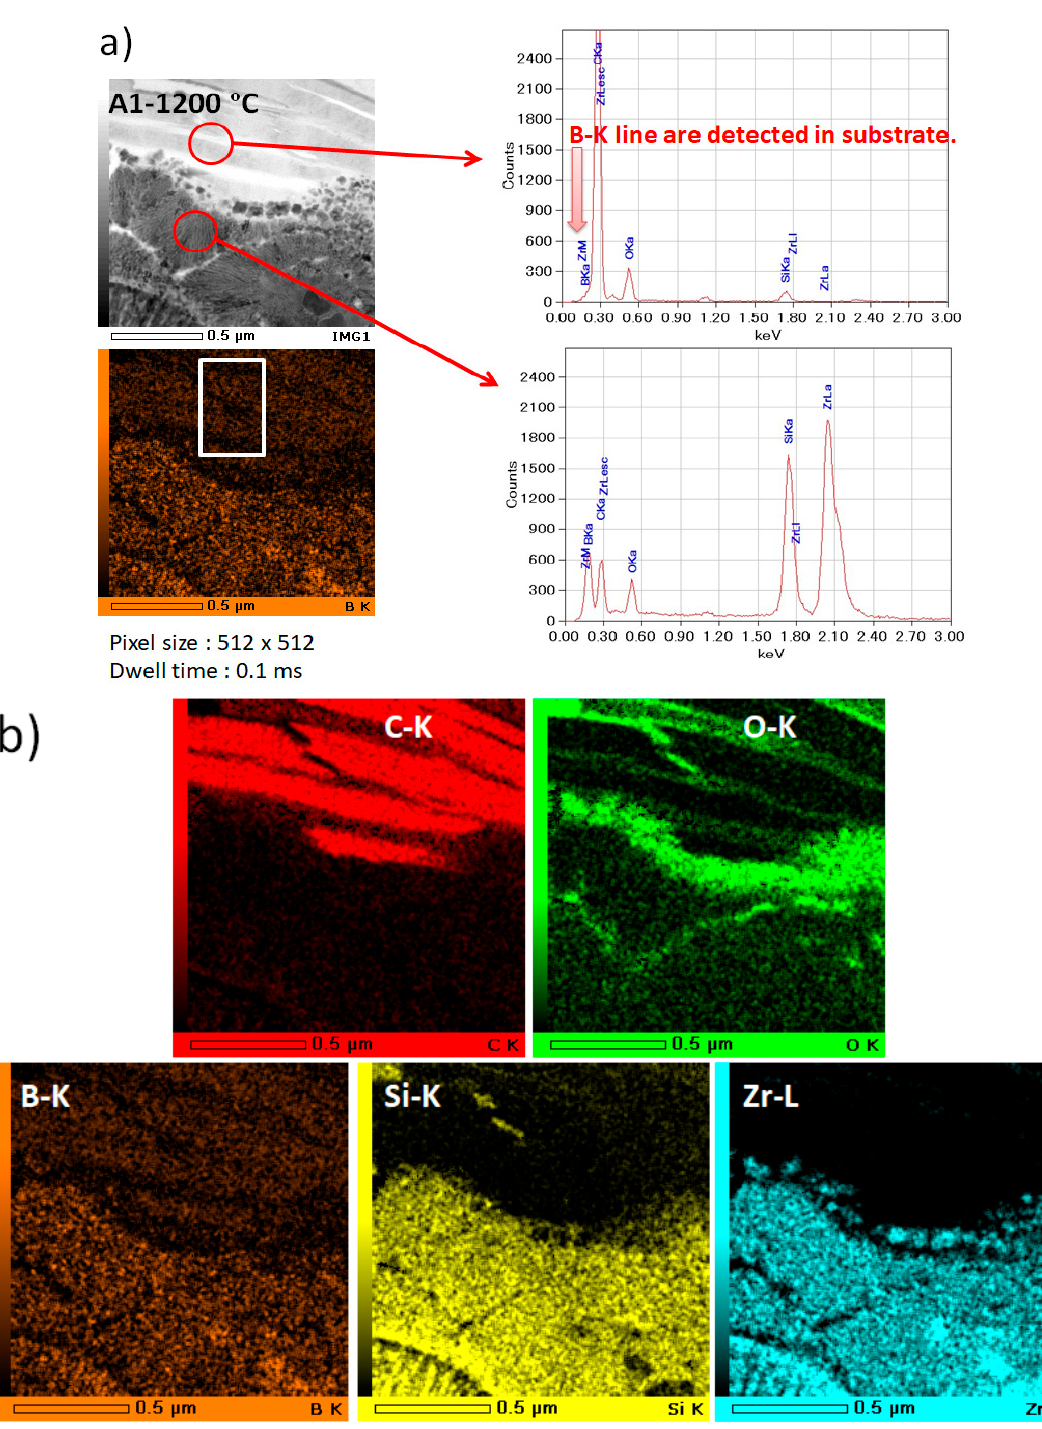
Figure 13. EDS/STEM analysis of coated sample A1 ( a ): STEM image with arrows indicating the EDX line scan position with Si K α signal and B K α signal of the particles; ( b ): the distributions of elements in 70%SiC-30%ZrB 2 at 1200 º C.